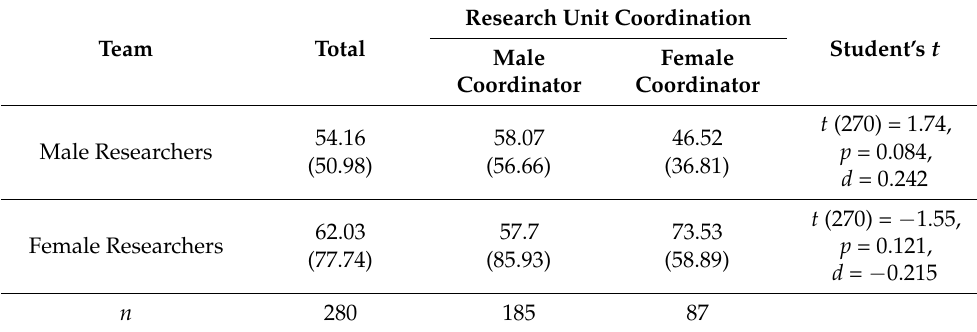
Table 5. Mean differences (standard deviations in parentheses) in the composition of R&D Units as a function of coordination (Student’s t